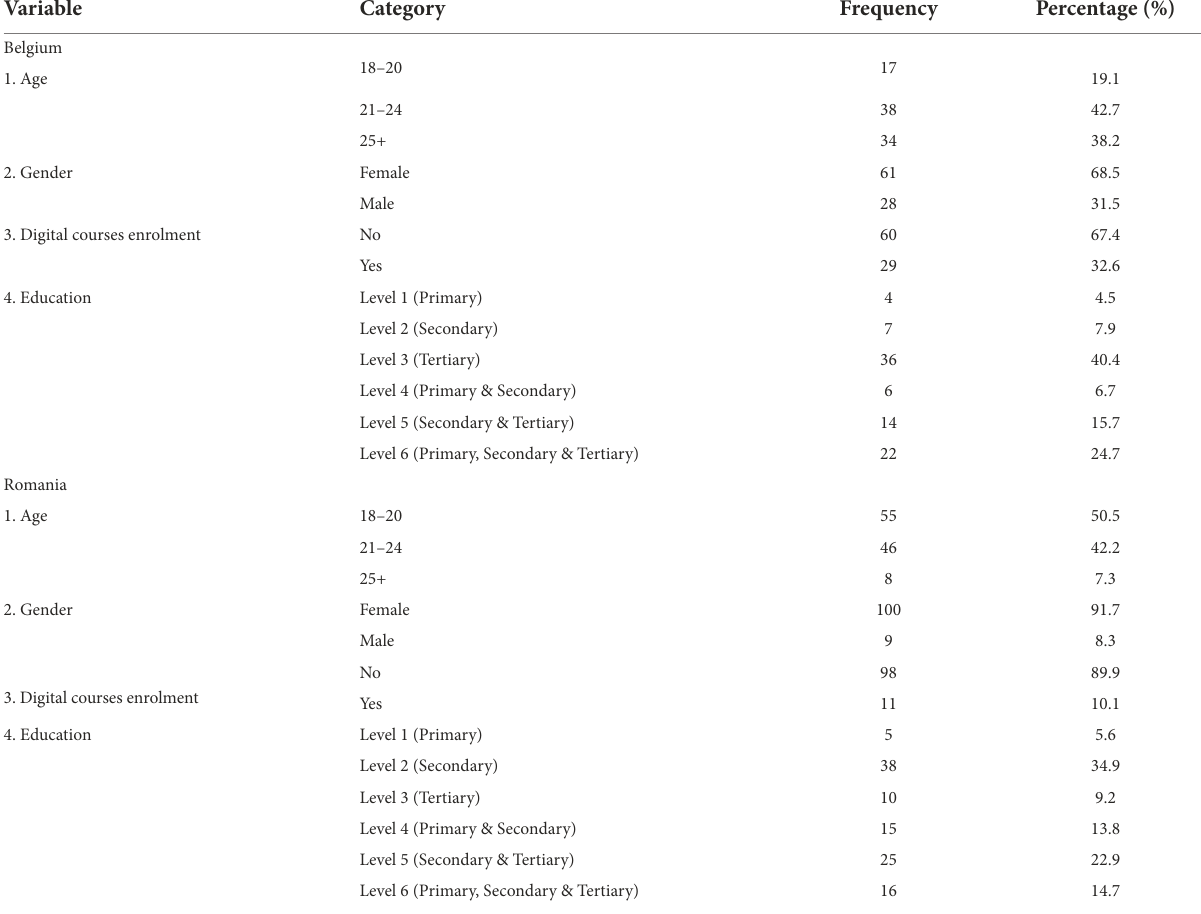
TABLE 3 Characteristics of students’ samples from Belgium and Romania ( n = 89 for Belgium and n = 109 for Romania).